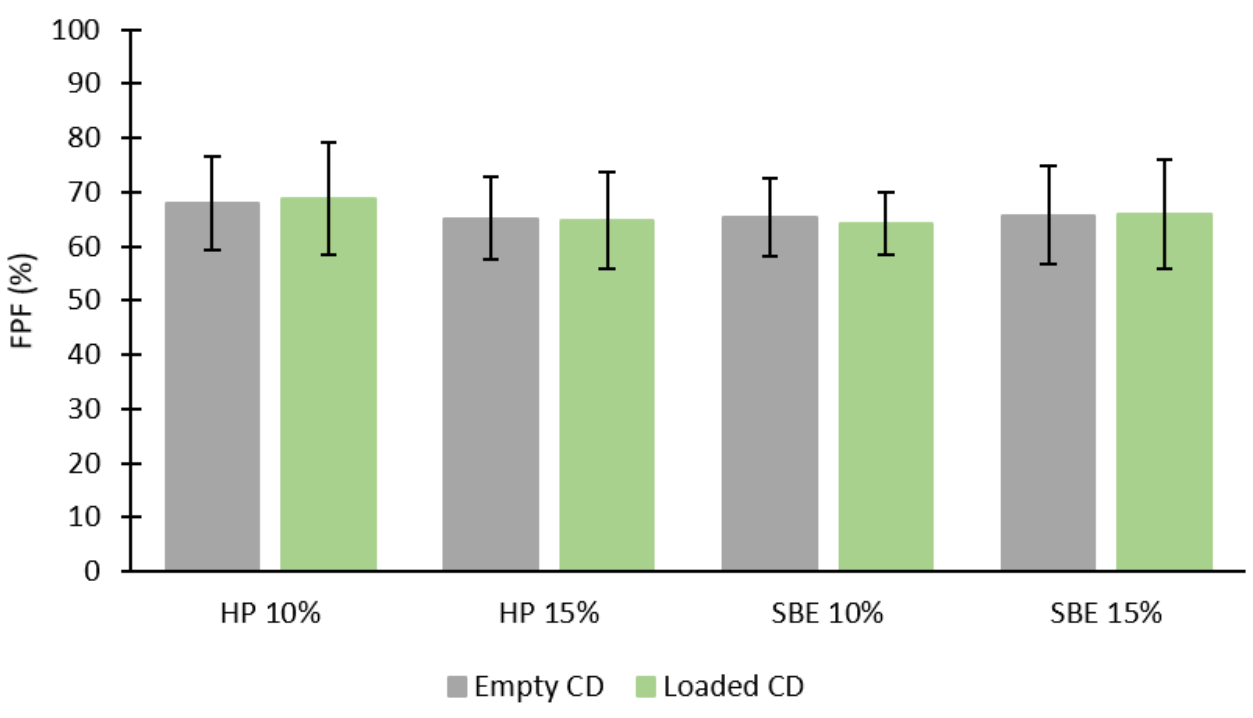
Figure 8. FPF of each empty CD (10% and 15%), and each CD (10% and 15%) loaded with DS (mean ± SD, n = 3).